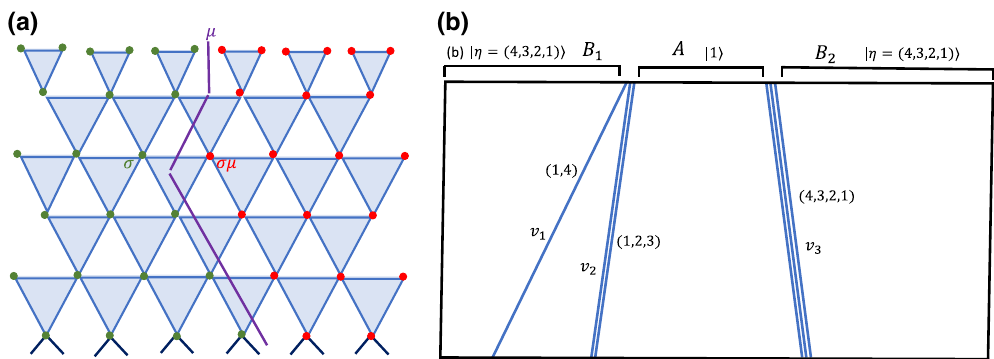
FIG. 20. A domain wall that separates σ spins on the left and σμ spins on the right is labeled by μ , as shown in (a). For the configuration shown in (b) (where we do not show the details of the lattice), the combined contribution from all domain walls is ( 2 ) (v ( 3 ) (v ( 4 ) (v q − E 1 ) t q − 2 E 2 ) t q − 3 E 3 ) t